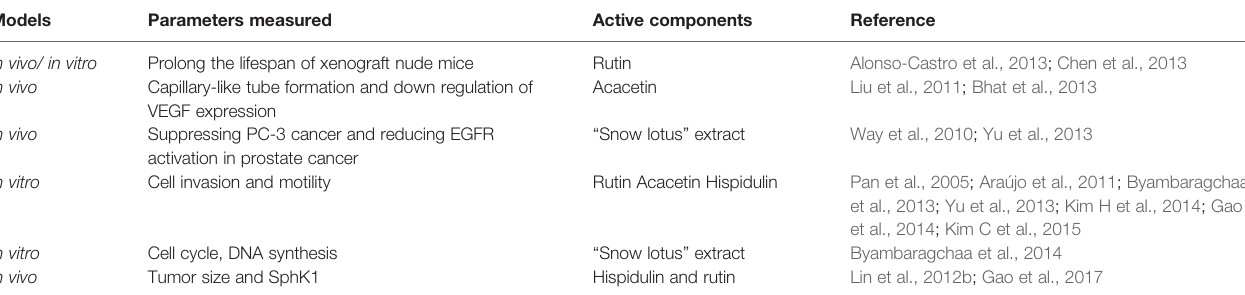
TABLE 4 | Summary of anti-cancer functions of “ Snow lotus ” and/or its major